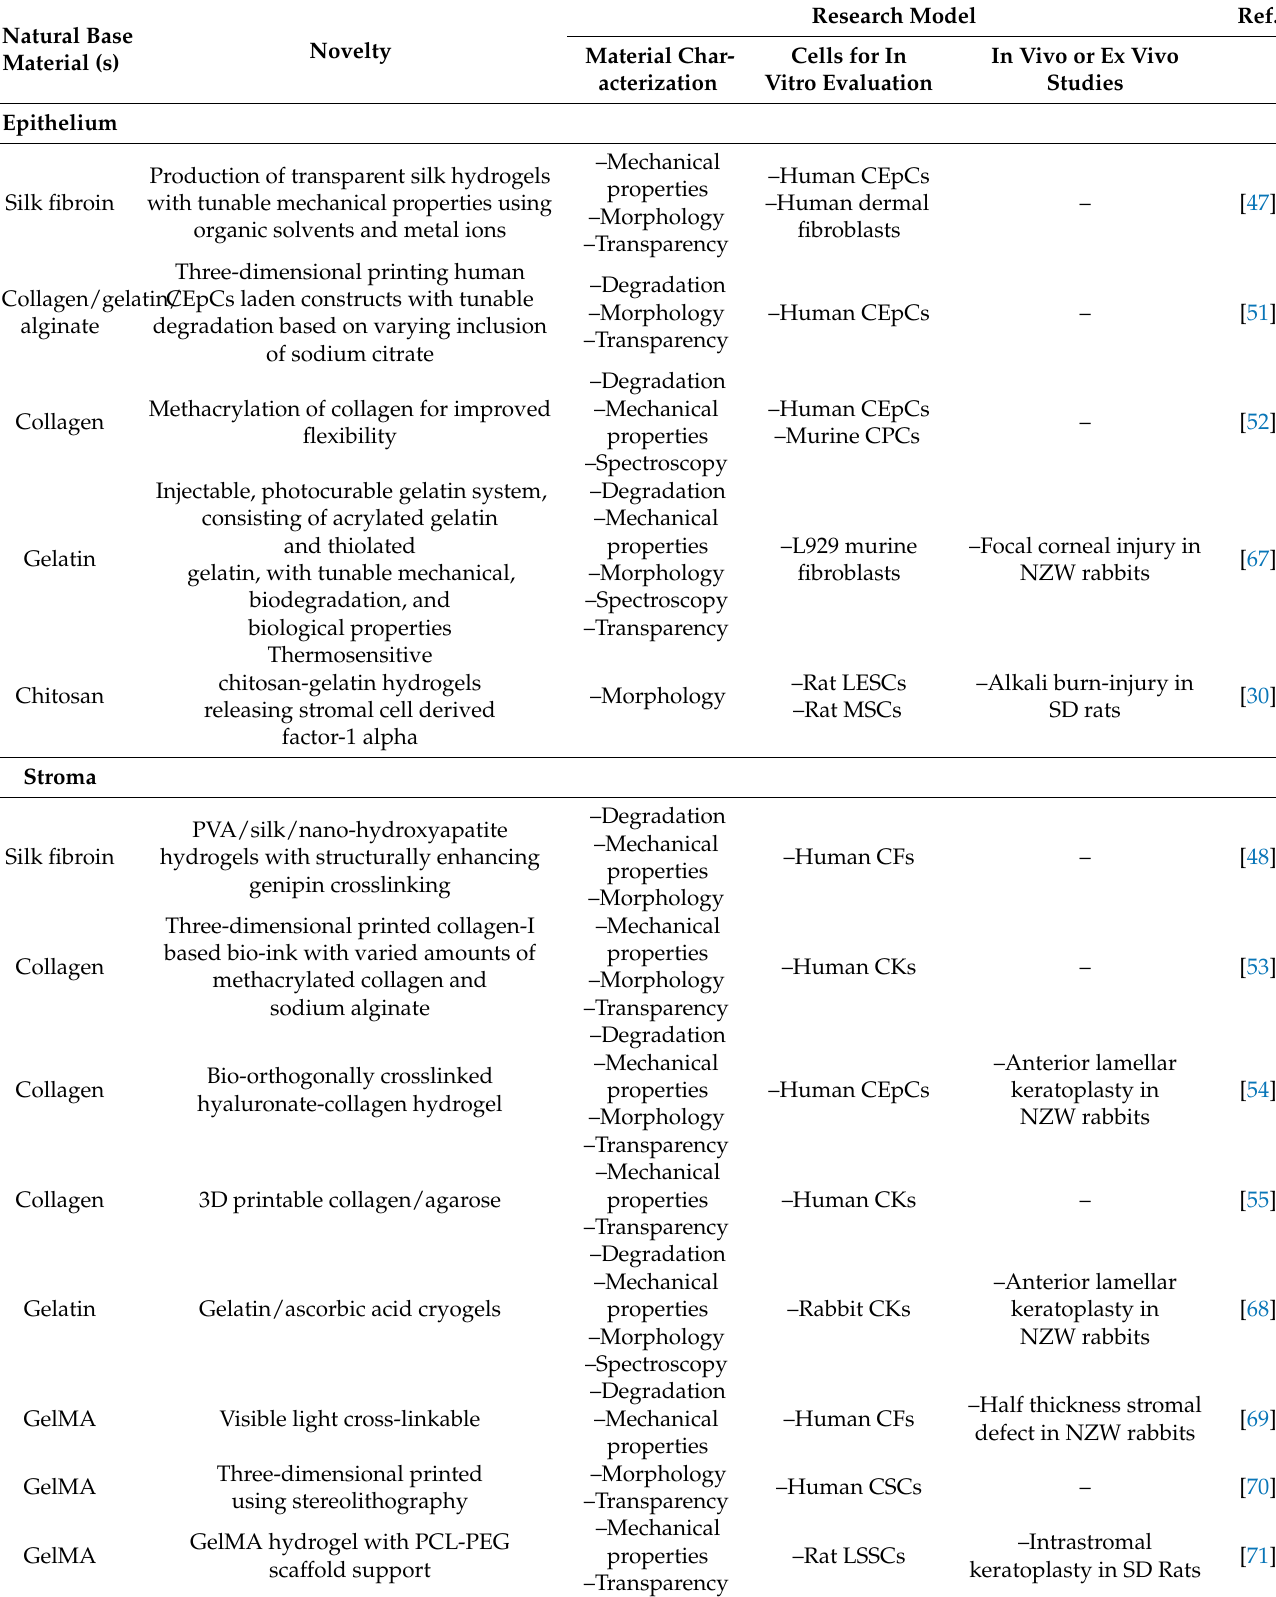
Table 2. Summary of current advances in natural hydrogel formulations for corneal tissue engineering. Natural